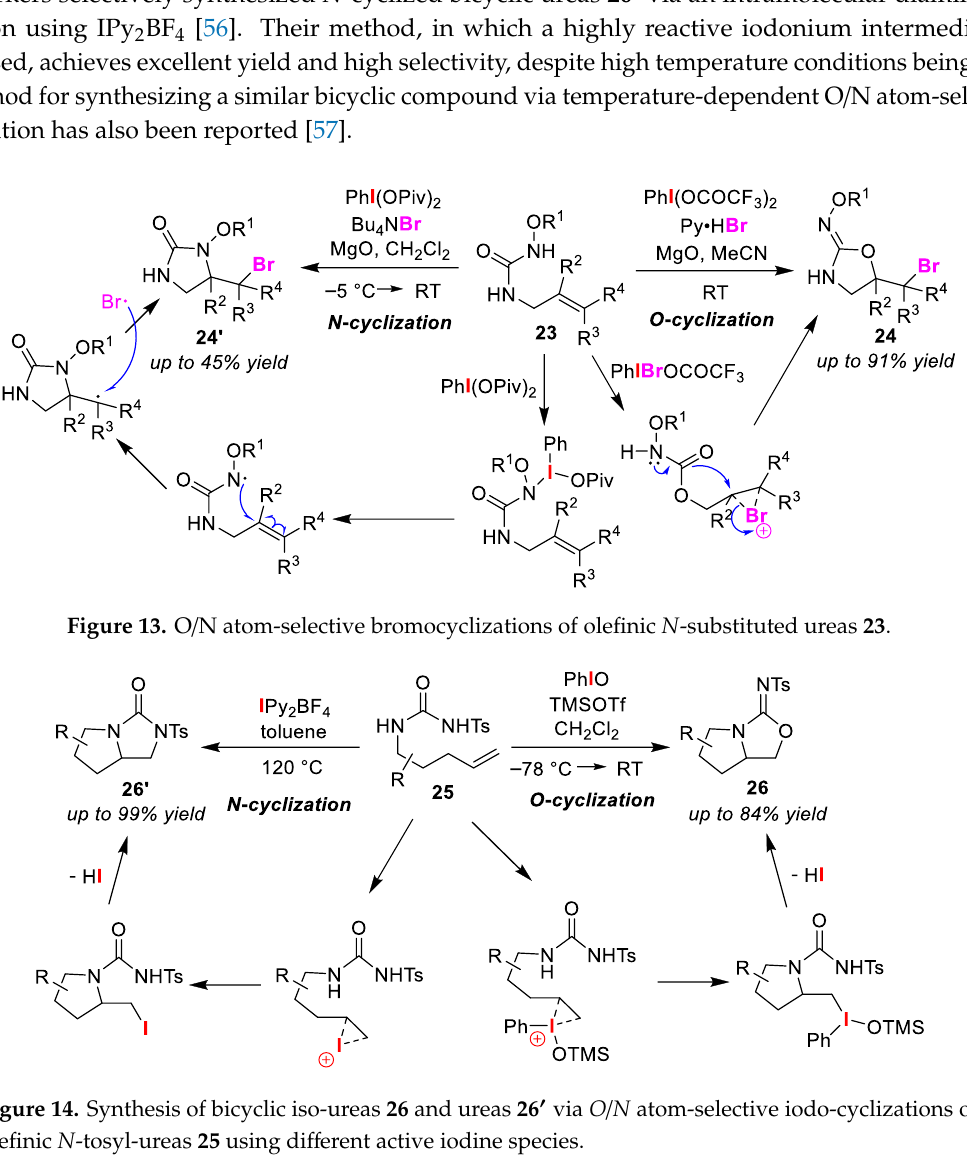
Figure 12. O/N atom-selective bromocyclizations of olefinic N -tosylcarbamates 21 .